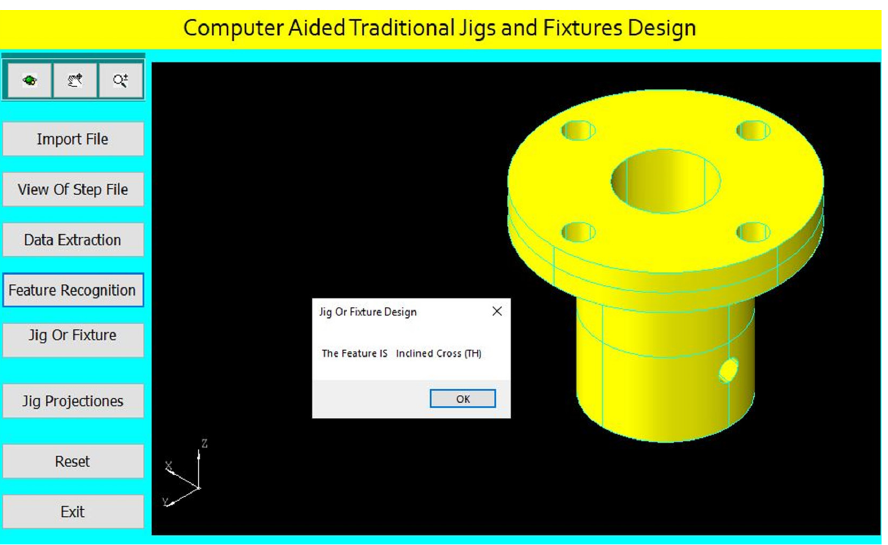
Figure 51. Automatic feature recognition of an inclined cross through-hole.